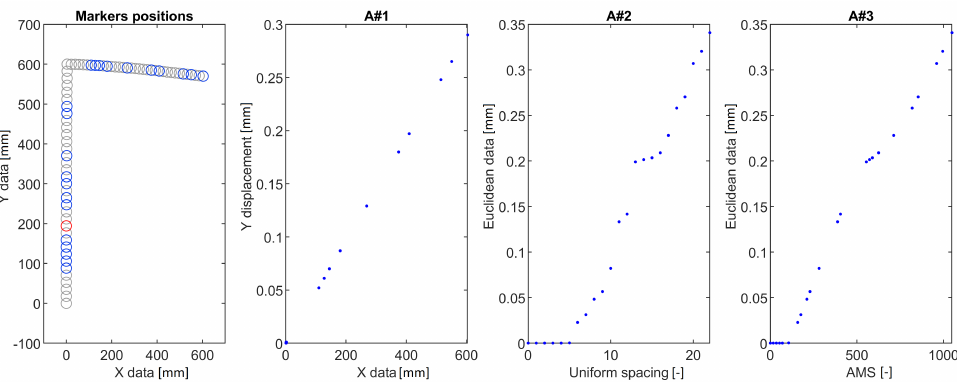
Figure 5. DDs for an L-shaped crane structure calculated using the three tested approaches. Blue circles denote points used for evaluation. Grey circles denote points randomly excluded from measurement. The red circle denotes the damage